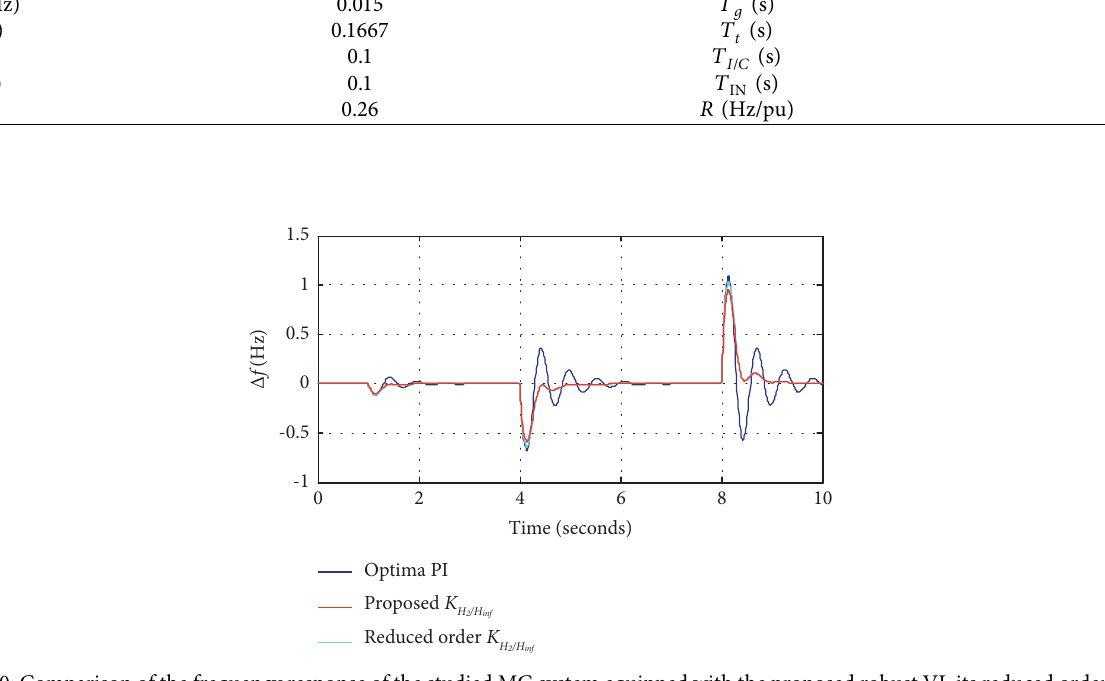
Figure 10: Comparison of the frequency response of the studied MG system equipped with the proposed robust VI, its reduced order form, and proposed intelligent self-tuning PI proposed in [37].